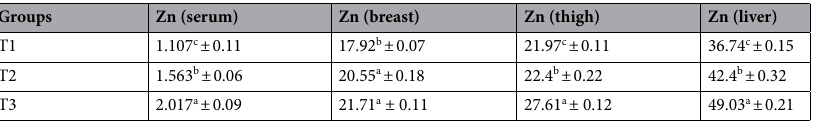
Table 5. Effects of ZnONPs supplementation on tissues and serum Zn concentration (ppm) of broiler chicks. Values are means ± SEM a, b, c—Means in the same column with different Superscripts are significantly different ( P <0.05)